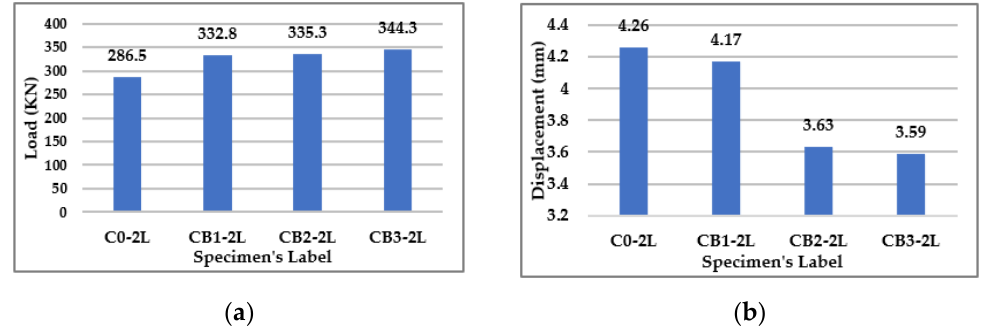
Figure 7. Results for Group (1). ( a ) Failure Loads for Group (1). ( b ) Deflection at the Mid Span of Beams in Group (1) at the same Load = 286.5 KN.